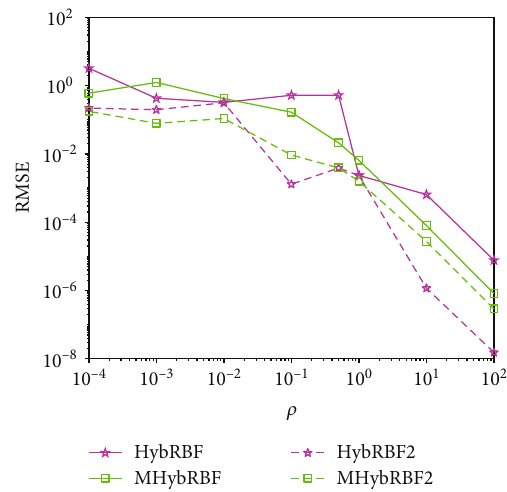
Figure 2: The comparison of RMSE of HybRBF, MHybRBF, HybRBF2, and MHybRBF2 with di ff erent ρ .